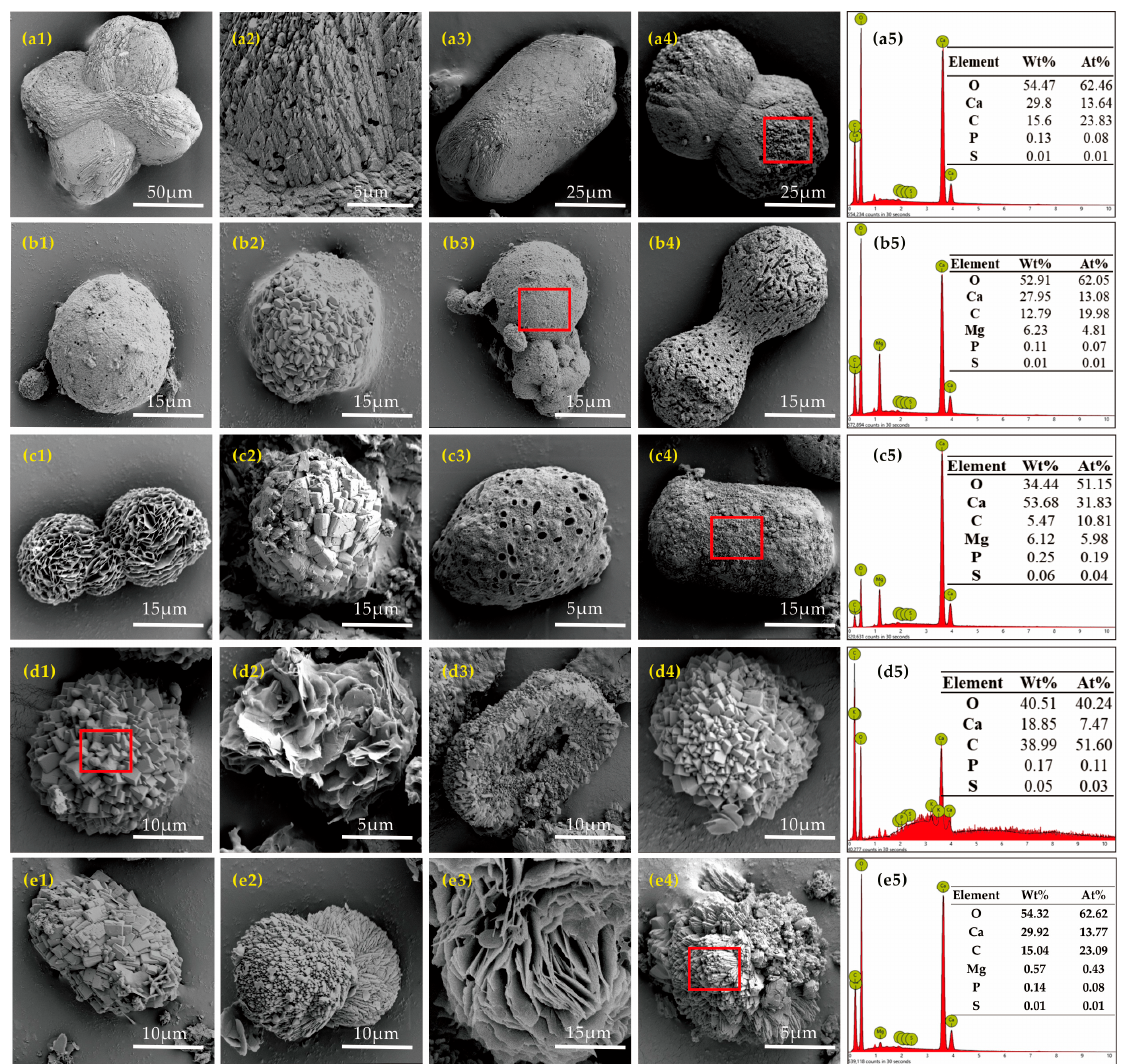
Figure 7. SEM and EDS analyses of minerals cultured for 30 days. ( a – e ), Mg / Ca molar ratios 0, 2, 5, 7, and 9, respectively. The red square shows the area analyzed by